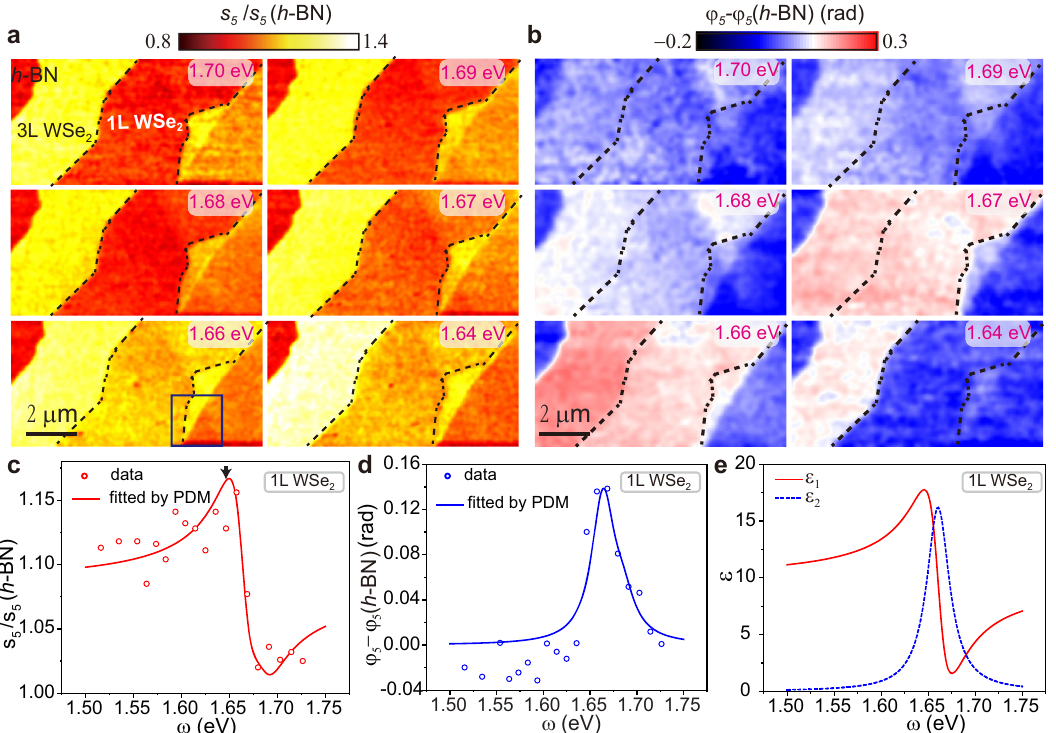
Fig. 2 Evolution of the scattering amplitude and phase for the monolayer WSe 2 as a function of the excitation energy. a Representative near- fi eld images of the normalized scattering amplitude s 5 ω ð Þ = s 5 ð h (cid:2) BN Þ . The excitation energies are indicated in the images, which are acquired by scanning over a rectangular area marked with the dashed line in Fig. 1d. Boundaries of the monolayer WSe 2 region are displayed with black dashed lines. The area enclosed ω ð Þ (cid:2) φ h (cid:2) BN ð Þ . The images with the same by blue lines in bottom left image was investigated in Fig. 4a. b Near- fi eld images of the normalized phase φ 5 5 excitation energy in a and b are acquired simultaneously. An analogous dataset demodulated at the fourth harmonic is shown in Supplementary Fig. 5. c , d ω ð Þ (cid:2) φ h (cid:2) BN ð Þ spectra for WSe Normalized near- fi eld amplitude s 5 ω ð Þ = s 5 ð h (cid:2) BN Þ and phase φ 2 monolayer (data points). Fits to the spectra using the 5 5 point dipole model (PDM) and a single Lorentz oscillator (Eq. 1) are shown as solid curves. The arrow in c marks the peak energy of PL spectra (Supplementary Fig. 4). e Dielectric function of WSe 2 monolayer extracted from the fi ts with PDM in ( c , d ).